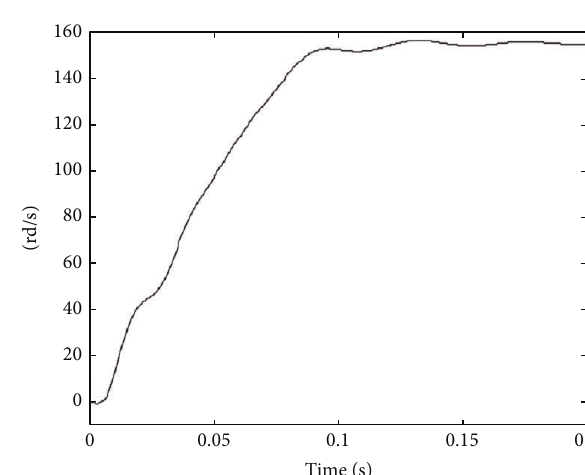
Figure 10: Rotor speed.